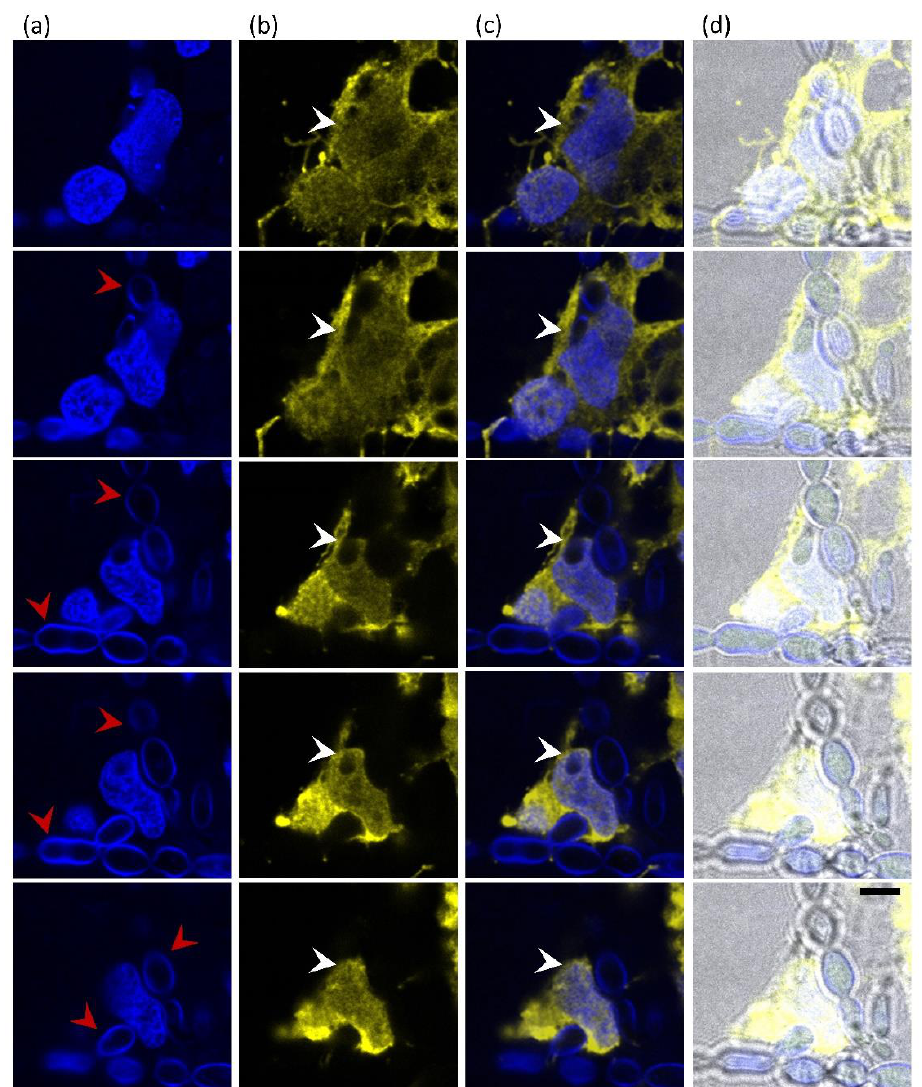
Figure 7. Internalization of Exophiala dermatitidis into neuroblastoma cells SH-SY5Y after 48 h incubation. Five confocal images, imaged as Z-stack (top to bottom row), show the interaction of SH-SY5Y neuroblastoma cells with E. dermatitidis . ( a ) Fungi were detected with Calcofluor White (CFW) and SH-SY5Y nuclei with DAPI, both in blue. Red arrows point to pseudohyphae. ( b ) SH-SY5Y cytoplasm was stained in yellow using anti-GAPDH antibodies and secondary antibodies conjugated to Alexa 555. Penetrating fungal cells in the cytoplasm of neuroblastoma cells are clearly visible in the sequential cell sections (white arrows). ( c ) Merged images from images ( a ) and ( b ), ( d ) merged images including bright field (BF). Scale bar: 5 μm.